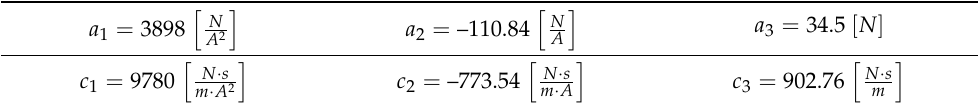
Table 1. The Bingham model